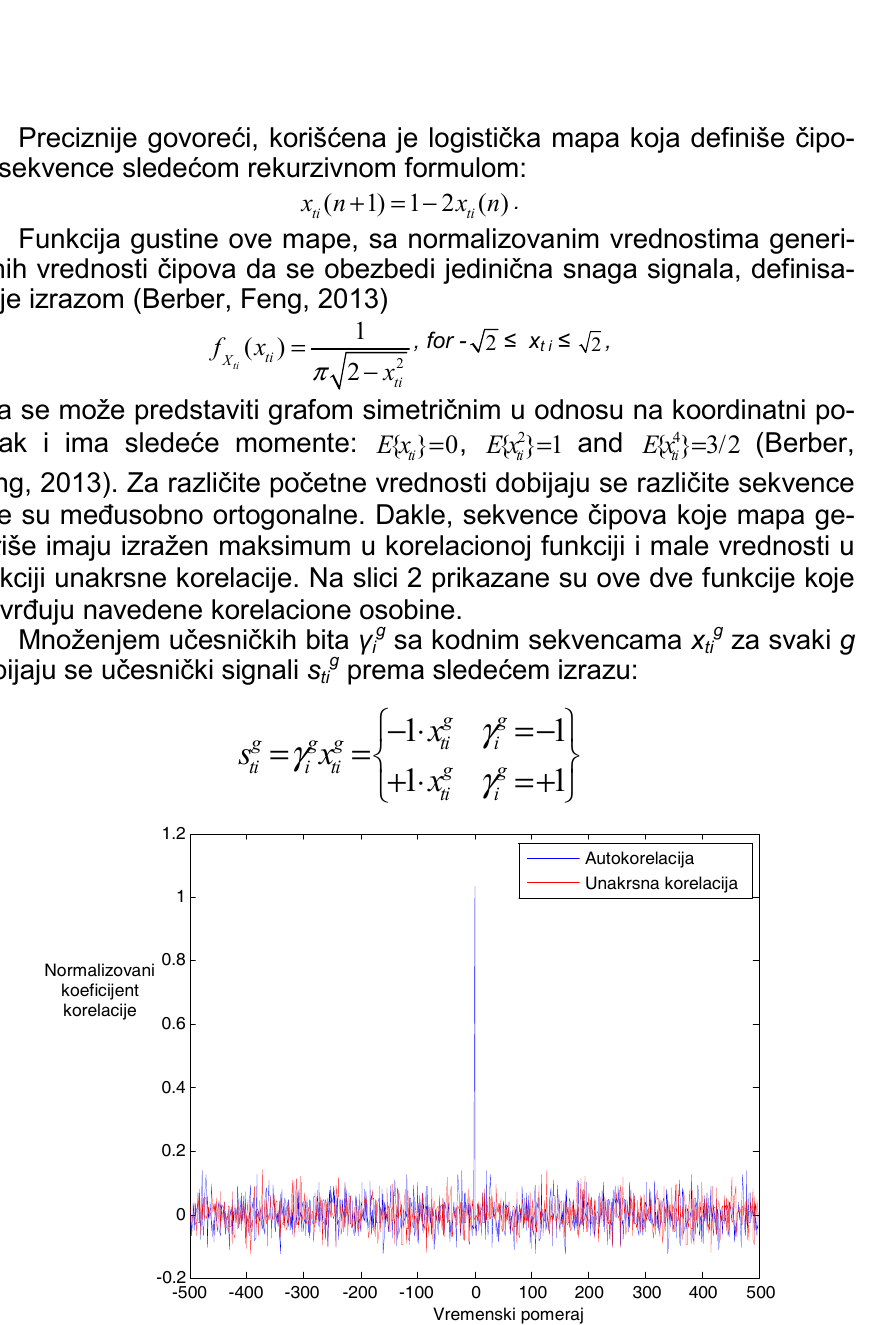
Figure 2 – Correlation and crosscorrelation functions for a chaotic sequence that is defined by the initial condition of a logistic